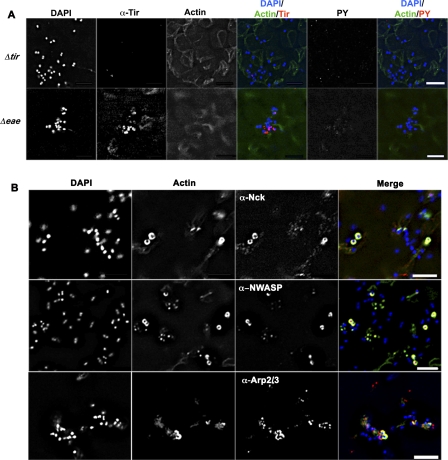
Actin Polymerization Induced by Extract in EPEC-Infected RBC Utilizes Both Bacterial and Host Factors(A) Images of RBC infected with EPEC mutants lacking Tir (EPECΔtir) or intimin (EPECΔeae) and treated with extract. Cells are labeled with DAPI to identify EPEC, Alexa-488 phalloidin to visualize actin, and either anti-Tir antibody or anti-PY 4G10 antibody.(B) Images of RBC infected with EPEC and treated with extract. Cells are labeled with DAPI to identify EPEC, Alexa-488-phalloidin to visualize actin, and either anti–Nck antibody, anti-WASP antibody, or anti-Arp 2/3 p21 antibody. Scale bars in all images represent 5 μm.